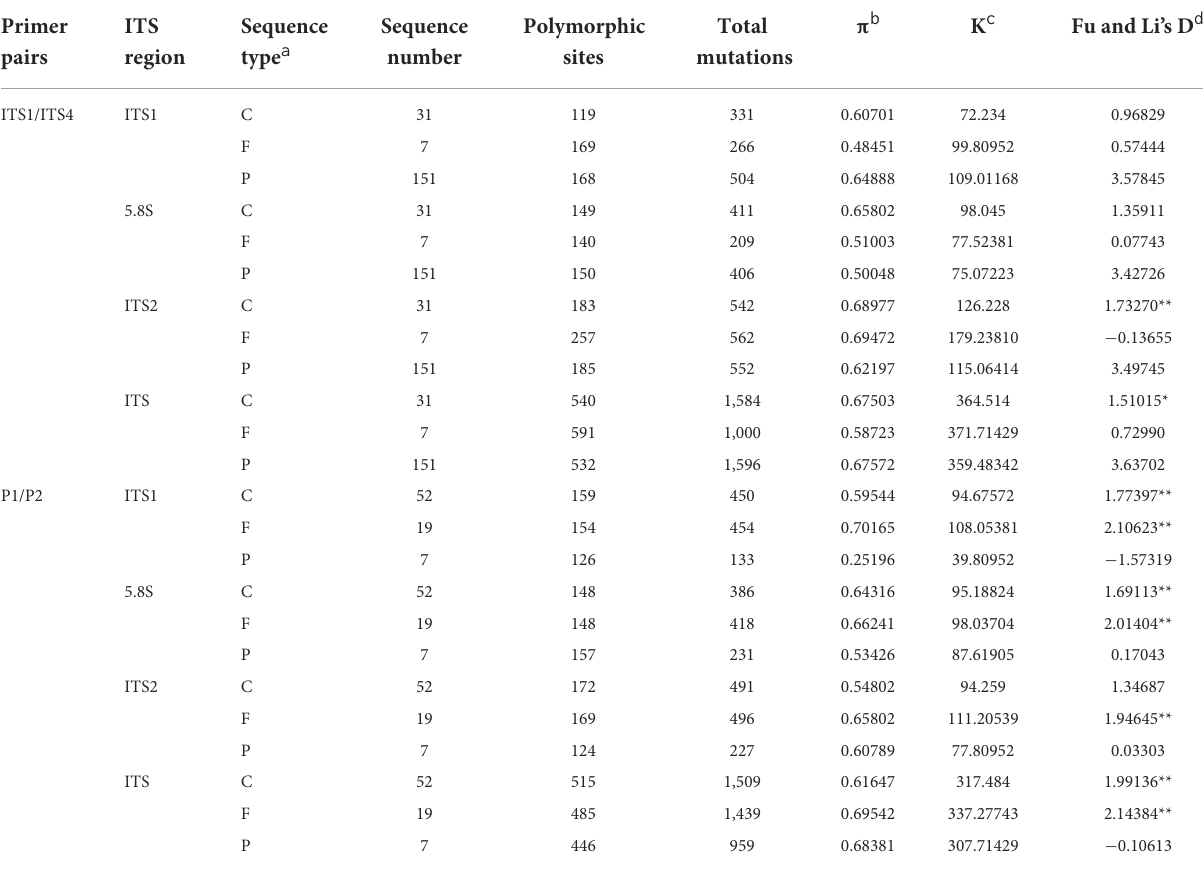
TABLE 3 Nucleotide diversity of individual parts and the entire ITS region in Lycium